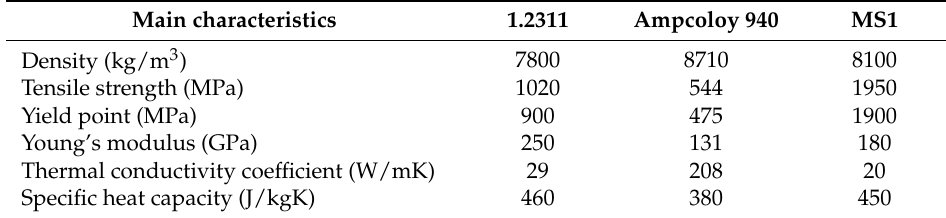
Table 2. The main characteristics of the materials used in the